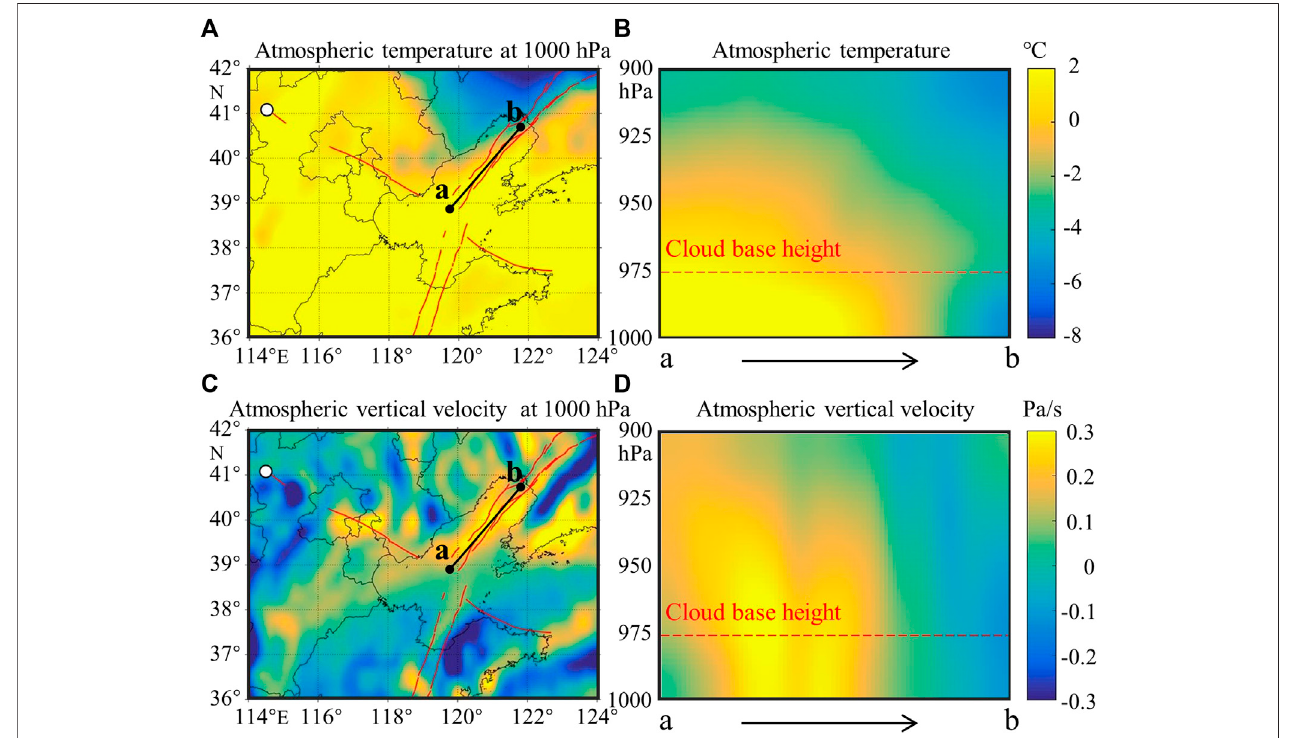
FIGURE11| Atmospherictemperature (A,B) andatmosphericverticalvelocity (C,D) overBohaiSeaat16:00on7January1998. (A) Theatmospherictemperature at 1,000 hPa. (B) The atmospheric temperature in different pressure layers along TLF (a-b direction). (C) The atmospheric vertical velocity at 1,000 hPa. (D) The atmospheric vertical velocity in different pressure layers along TLF (a-b